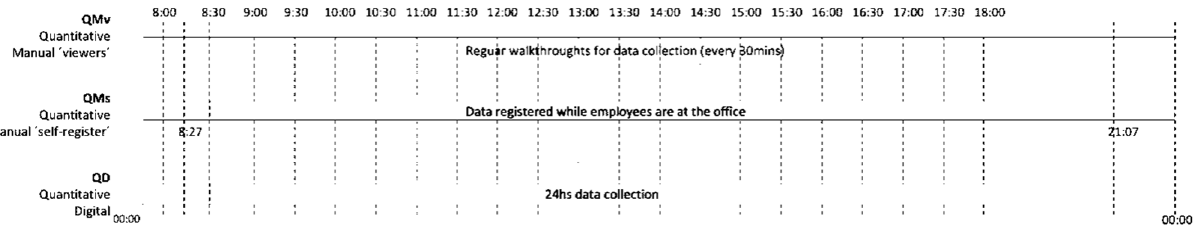
Figure 3. Data collection schedule for the 3 data collection methods: QMv, punctual data collection through walkthroughs; QMs, continuous data collection while employees are present; QD, continuous data collection 24 h.